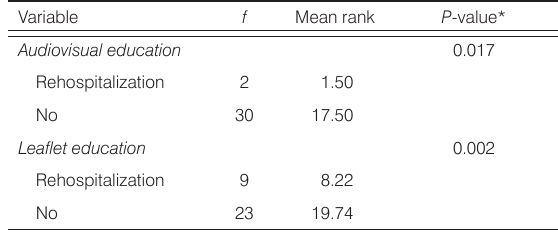
Table 2. The effect of post–health-education knowledge on rehospitalization (N = 64). Group